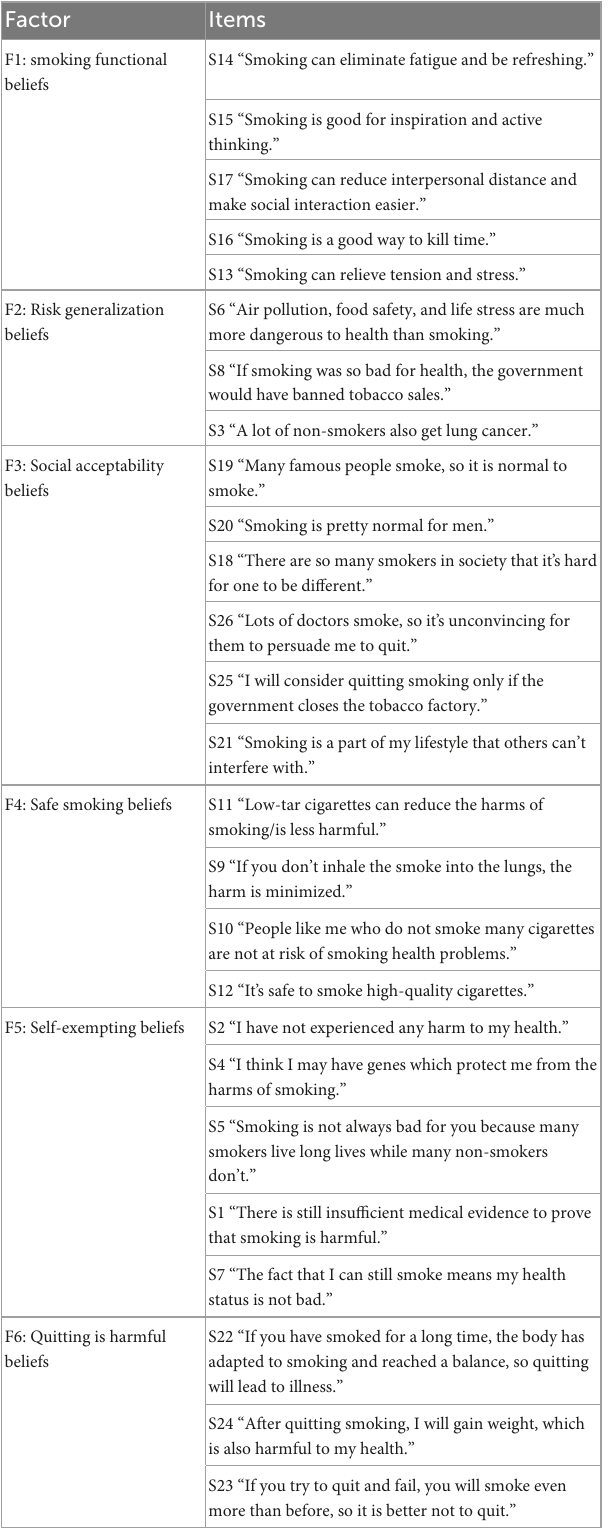
(1) Having severe mental illness and cognitive impairment; (2) refusing to participate in this study. The sample size of the each subsample should be 5–10 times of the number of the original scale items (25). Assuming that the invalid questionnaire rate